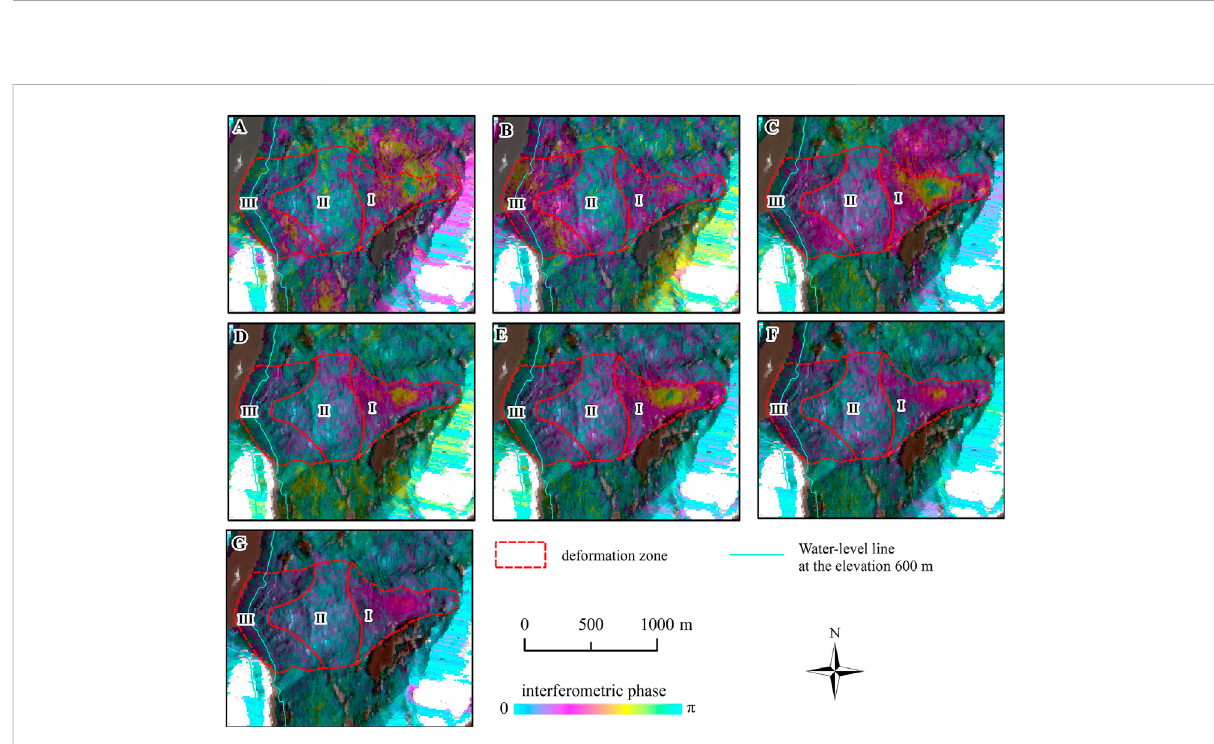
FIGURE 10 PRE-InSAR results of NLJLfrom differentperiods. (A) PRE-InSAR in 2015; (B) PRE-InSAR in2016; (C) PRE-InSAR in2017; (D) PRE-InSAR in2018; (E) PRE-InSAR in 2019; (F) PRE-InSAR in 2020; (G) PRE-InSAR in 2021.